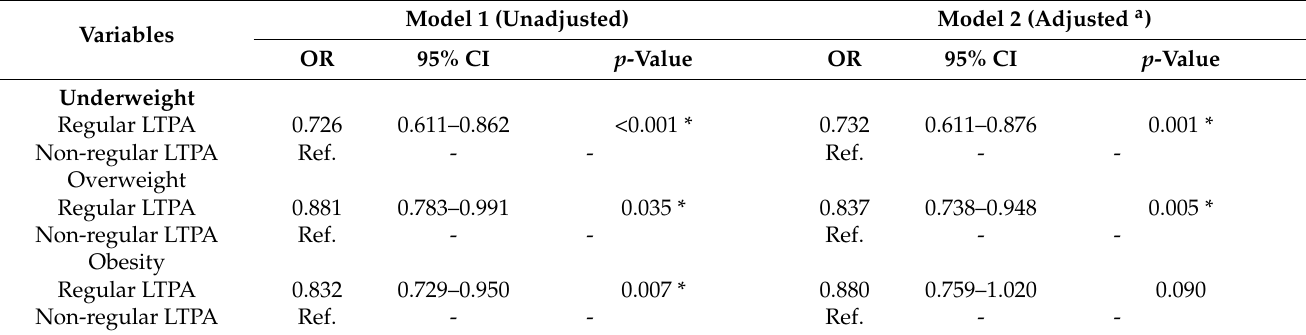
Table 3. Multivariate logistic regression for regular LTPA to underweight, overweight, and obe- sity